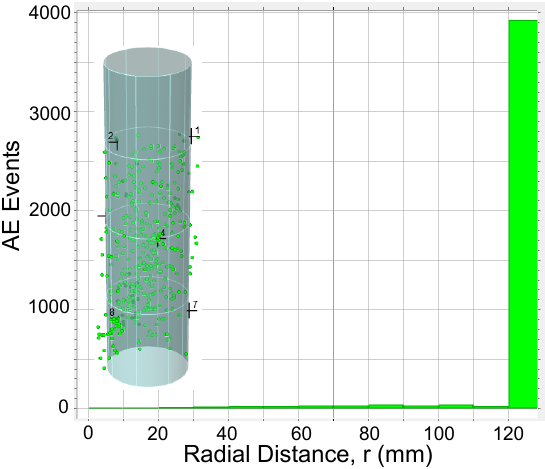
Figure 14. AE events along specimen F06S120L cross section for t < 180s.